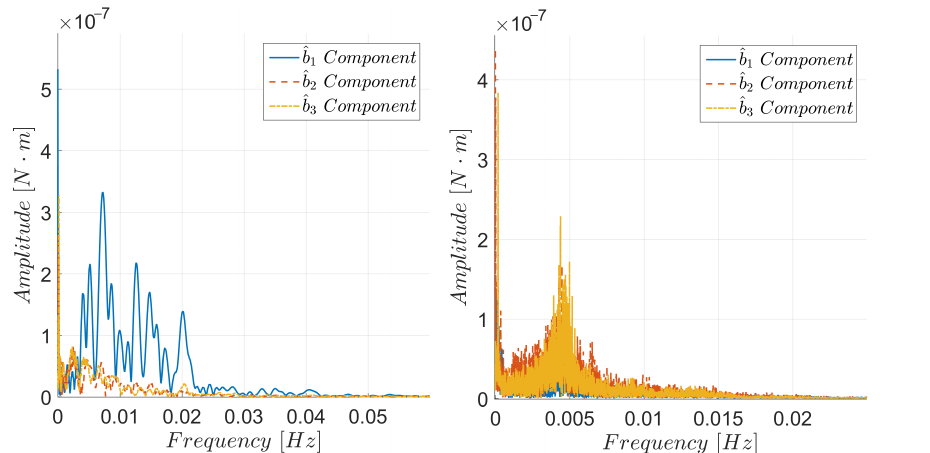
Figure 15. FFT of the torques applied to the target ( left ) and chaser ( right )